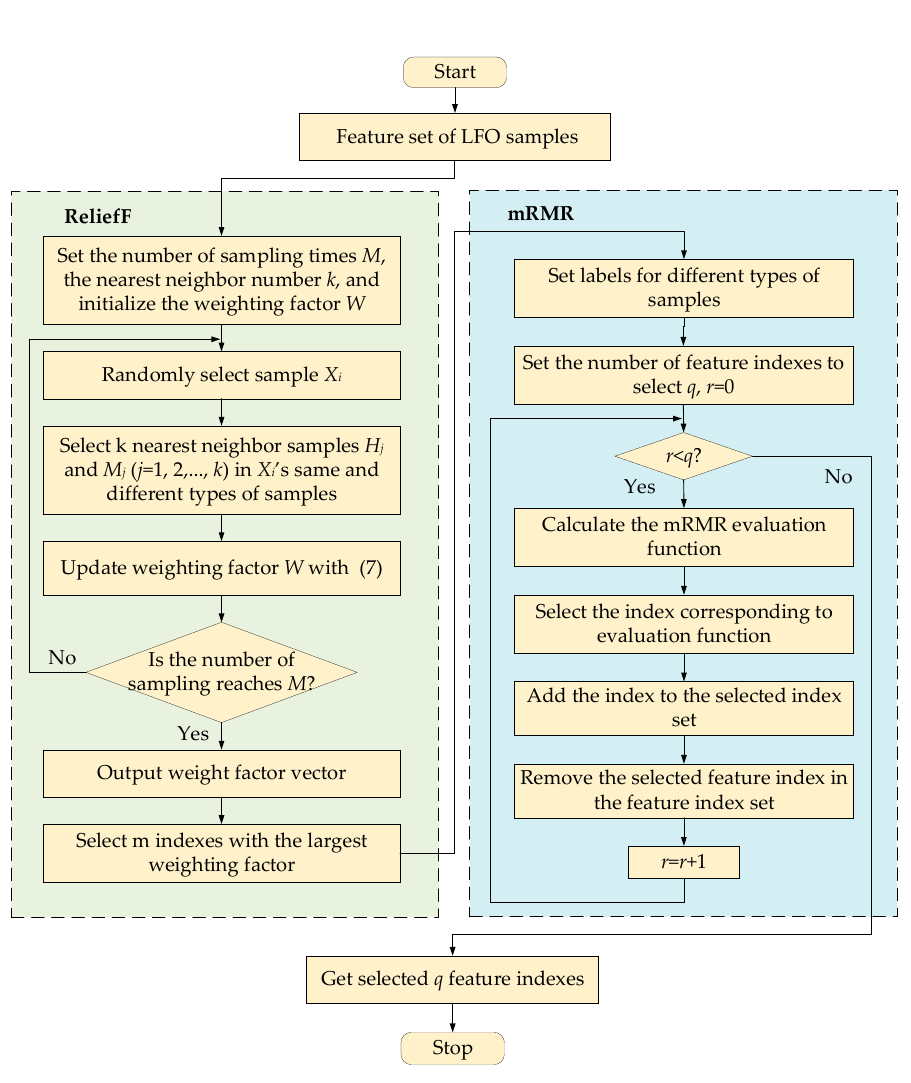
Figure 1. Flow chart of LFO feature subset selection based on ReliefF-mRMR.